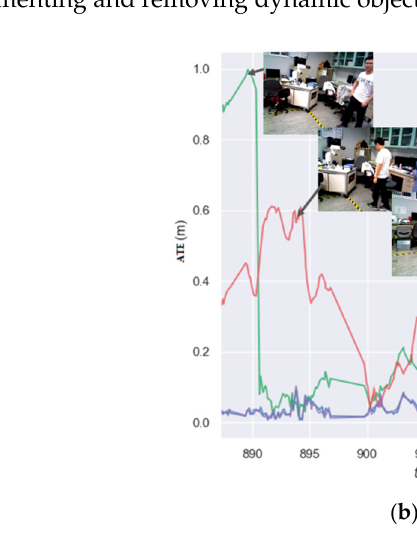
Figure 13. The ATE distribution for four dynamic SLAM algorithms on two real dynamic sequences: OPF-SLAM (green), ORB-SLAM2 (red), Dyna-SLAM (blue), and PFD-SLAM (purple); ( a ) Seq01; ( b ) Seq02.